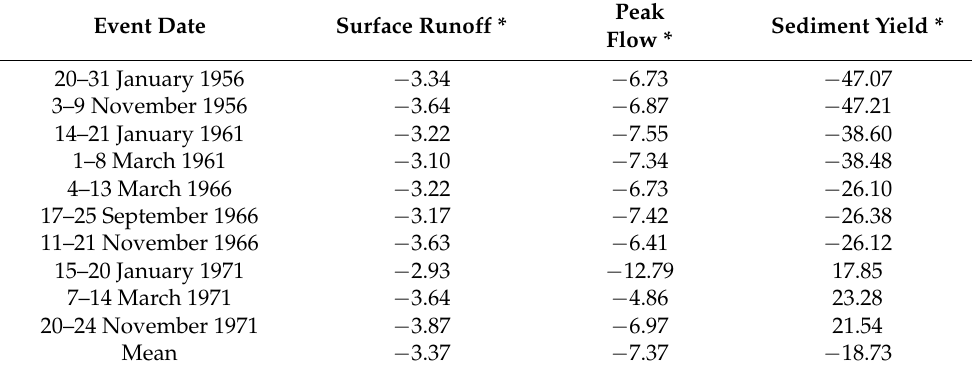
Table 4. Percent difference in hydrological simulations using the HEC-HMS and MUSLE models between the Vacale and Serra torrents (Calabria, Southern